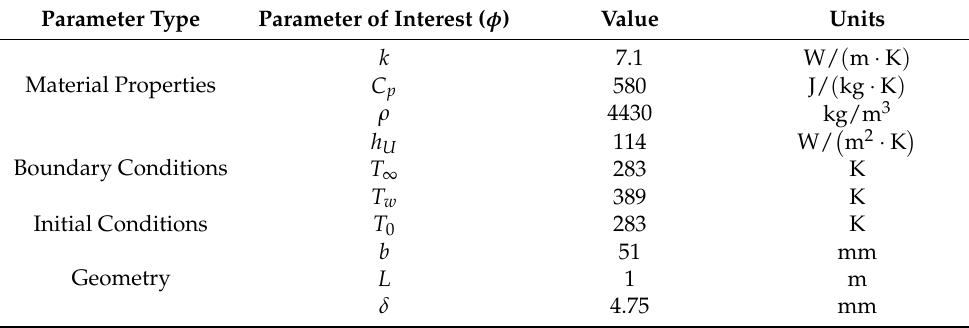
Table 1. Parameters involved in the transient thermal fin problem.